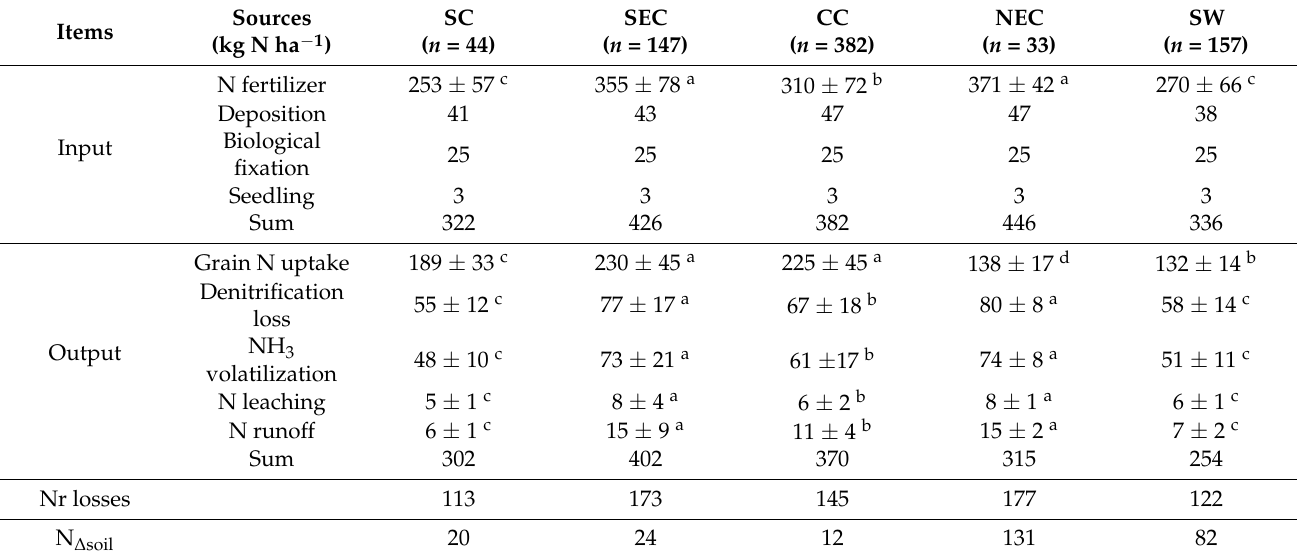
Table 1. Estimation of the seasonal N stored (N ∆ soil ) in soil in RR system in five areas in